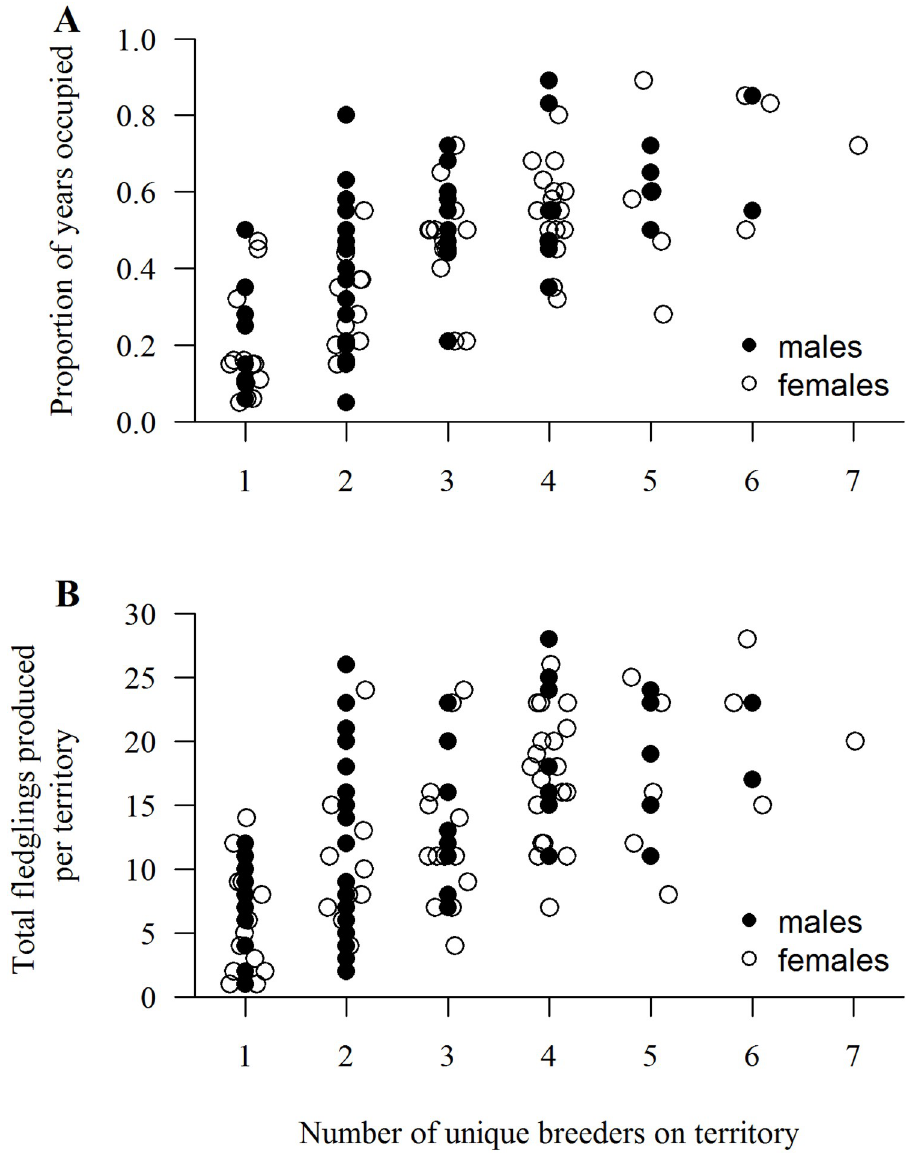
Fig 16. The number of unique breeders on a territory in relation to frequency of territory-specific occupancy and total fledgling production. (A) Numbers of sequential breeding male and female goshawks on each of 36 territories monitored for 20 years in relation to (A) the number of years each territory had breeders, and in relation to (B) the 20-year total fledglings produced on each of the 36 territories in Arizona, USA.